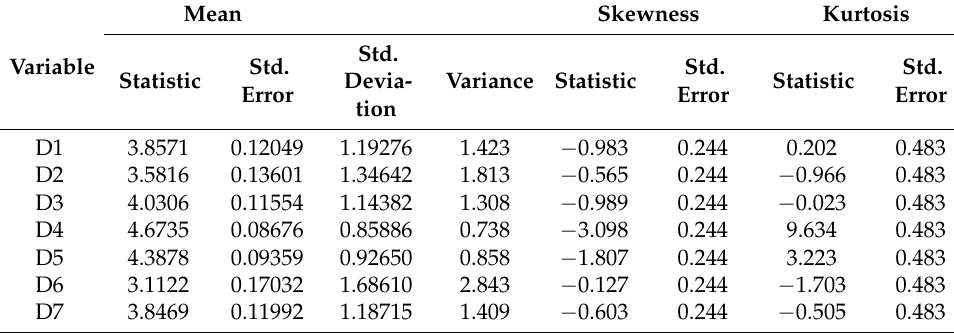
Table 3. Descriptive statistics of Accessibility